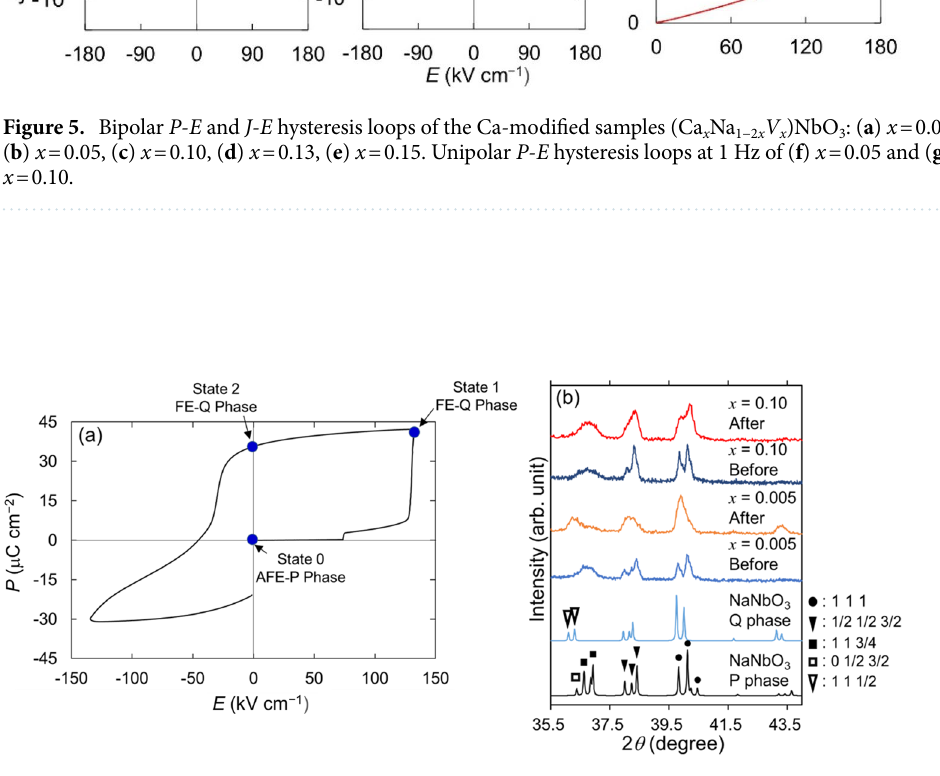
Figure 6. ( a ) First cycle of the bipolar P - E hysteresis loop for the unpoled sample with x = 0.05. ( b ) Micro-XRD patterns of the Ca-modified samples (Ca x Na 1−2 x V x )NbO 3 with x = 0.005, 0.10 after the P - E measurements. The data for powders with the same compositions are also shown, which are denoted by ‘before’. The solid circles, triangles, and squares indicate 1 1 1, 1/2 1/2 3/2 and 1 1 3/4 reflections 55 , respectively, and the open rectangular and triangles indicate 0 1/2 3/2 and 1 1 1/2 reflection, respectively. The data of NaNbO 3 in the P and Q phases are referenced from 00–033–1270 51 and 01–079–7429 52 in ICDD,